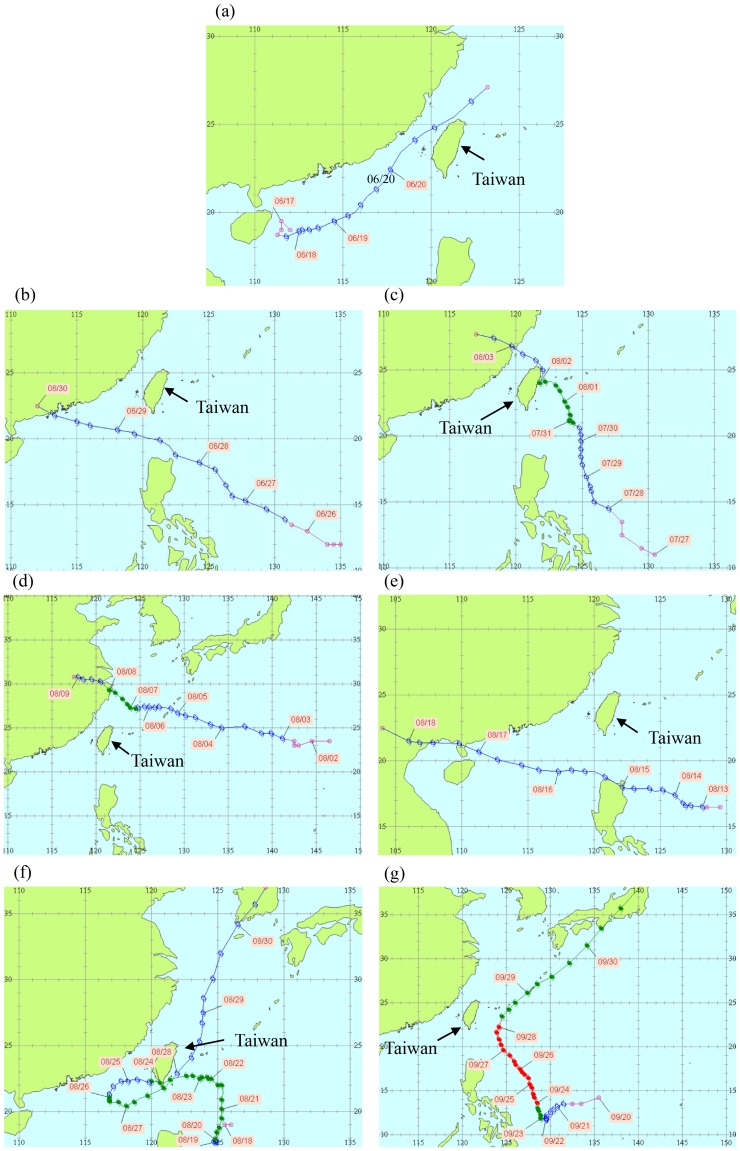
The path of (a) Talim, (b) Doksuri, (c) Saola, (d) Haikui, (e) Kai-Tak, (f) Tembin and (g) Jelawat Typhoon from Taiwan Central Weather Bureau.